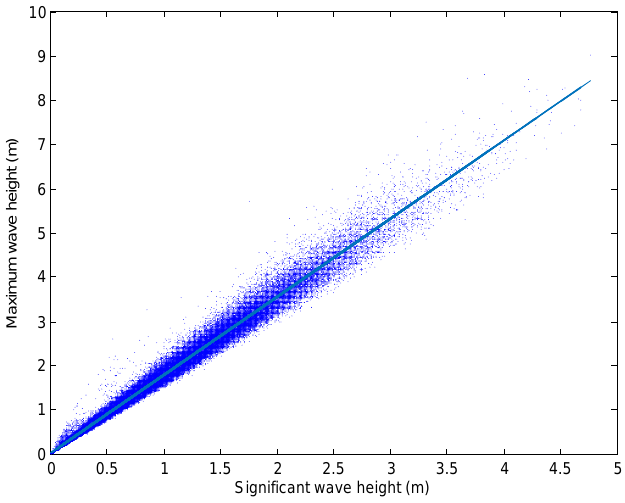
Figure 9. Maximum wave height versus significant wave